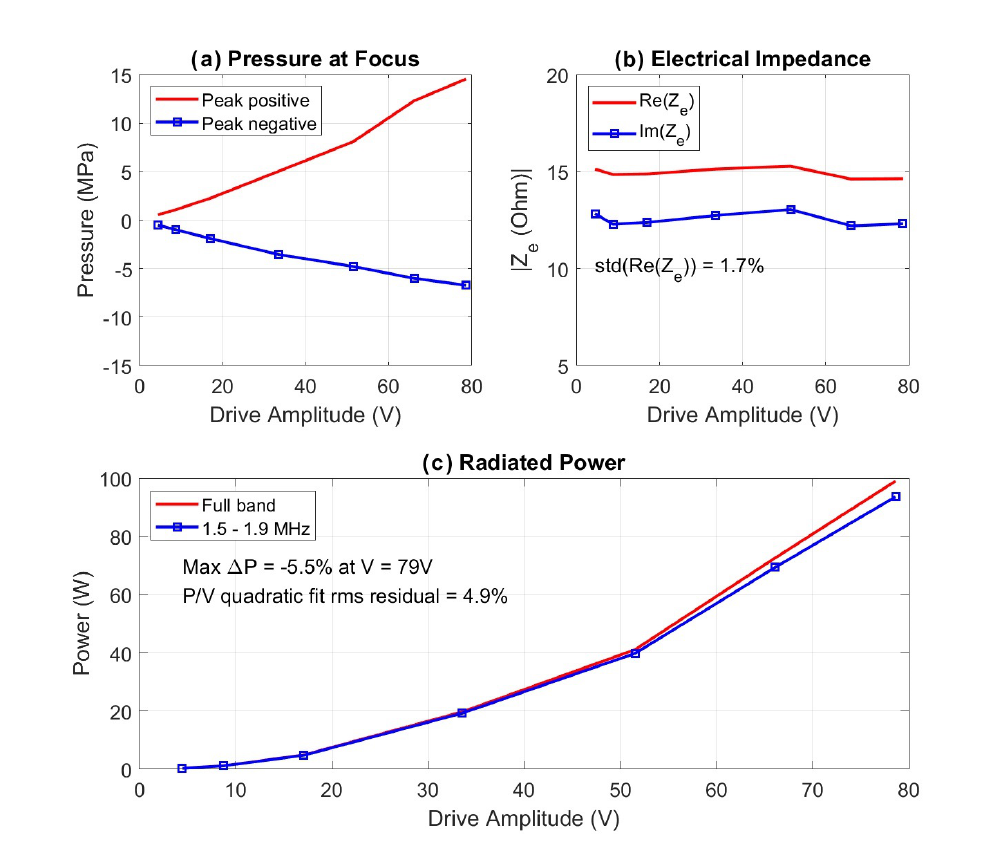
Figure 6. Validation of the small-signal electrical impedance measurement results to higher driver voltages (resulting in higher pressures and powers). ( a ) Focal pressure, ( b ) electrical impedance, and ( c ) radiated power measurements as a function of drive voltage in the range of 4–80 V showing the linearity of the pressure-voltage correlation, in the case of the third harmonic band ( ∼ 1.7 MHz) of the H-107 (SN: 031)